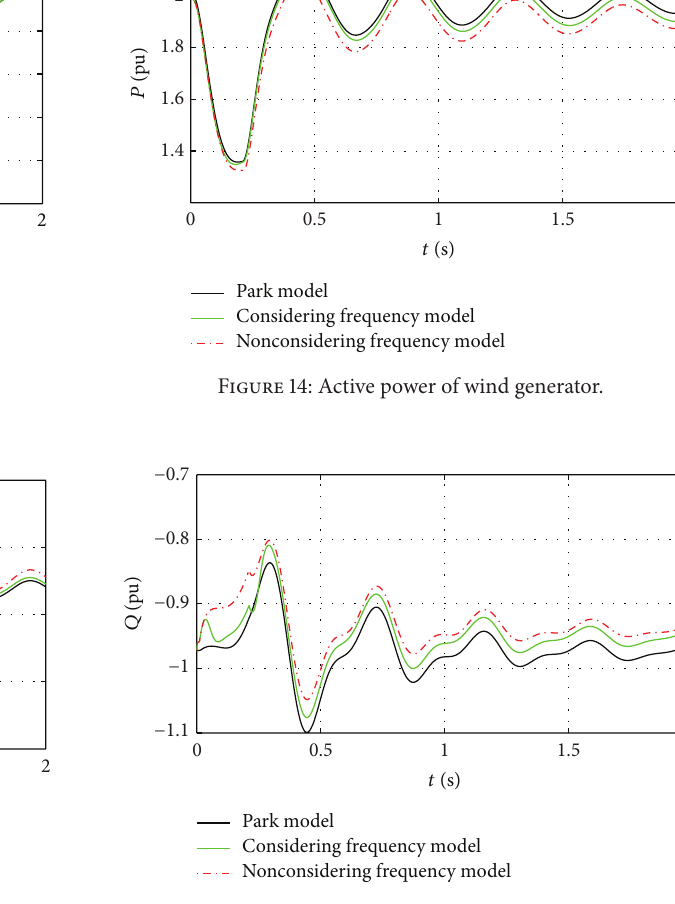
Figure 15: Reactive power of wind